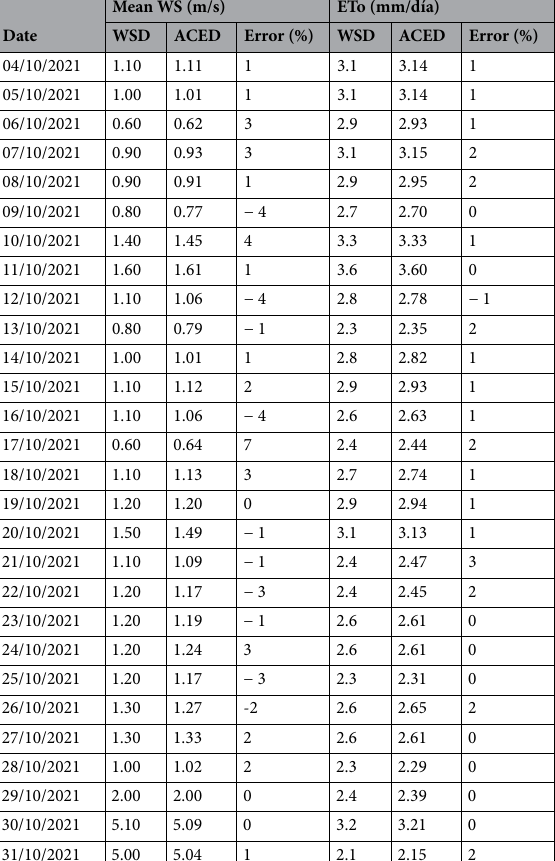
Table 5. Comparison for wind speed and ETo data obtained by the AgroClimatic web application and by the Meteorological Data Service. WS: Wind